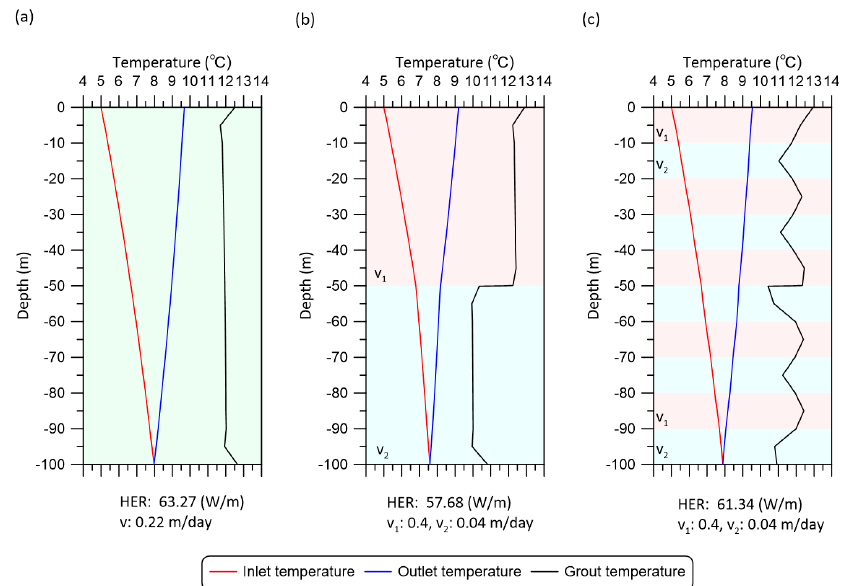
Figure 16. Temperature distribution in the borehole and result of the GHE simulation. Groundwater flow velocity was set as ( a ) v : 0.22 m/day, ( b ) v 1 : 0.4 m/day at depth of 0 to 50 m and v 2 : 0.04 m/day flow velocity was set as ( a ) v : 0.22 m / day, ( b ) v 1 : 0.4 m / day at depth of 0 to 50 m and v 2 : 0.04 m / day at at depth of 50 to 100 m, and ( c ) v 1 : 0.4 m/day and v 2 : 0.04 m/day, which are entered alternately every 10 m in depth. Figure 16a is the same as Figure 5a, and Figure 16b is the same as Figure 5c. depth of 50 to 100 m, and ( c ) v 1 : 0.4 m / day and v 2 : 0.04 m / day, which are entered alternately every 10